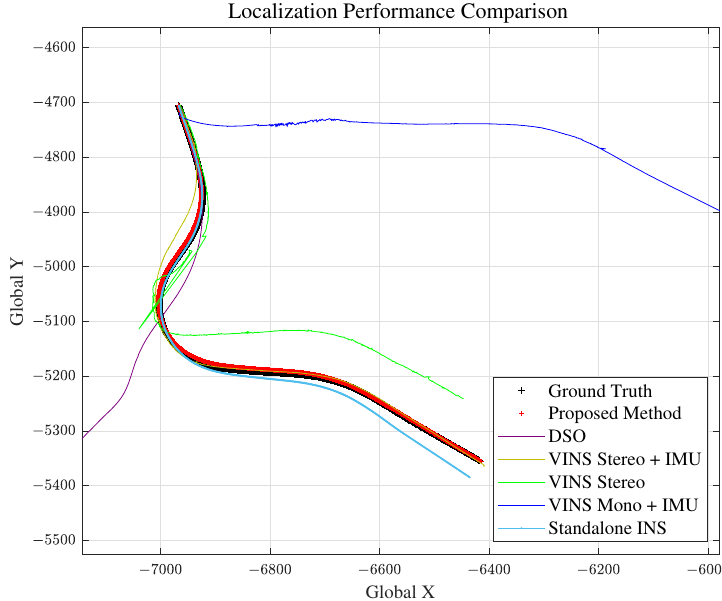
Figure 16. Scenario 3: Vehicle Localization with Various Methods.